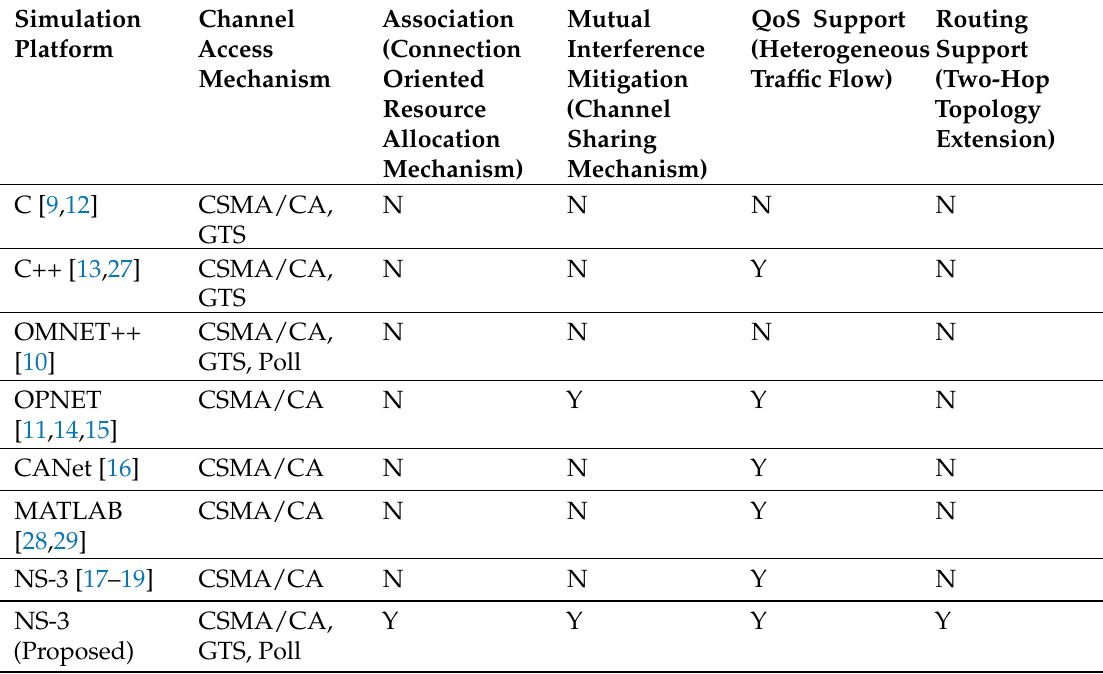
Table 1. Comparison of wireless body area network (WBAN) simulation